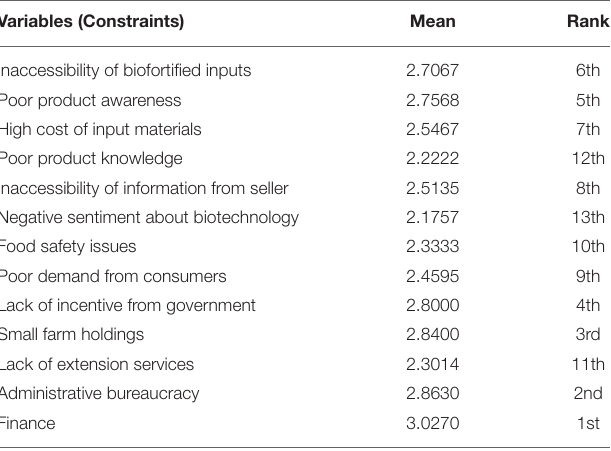
TABLE 3 | Constraints against production and marketing of biofortified cassava by